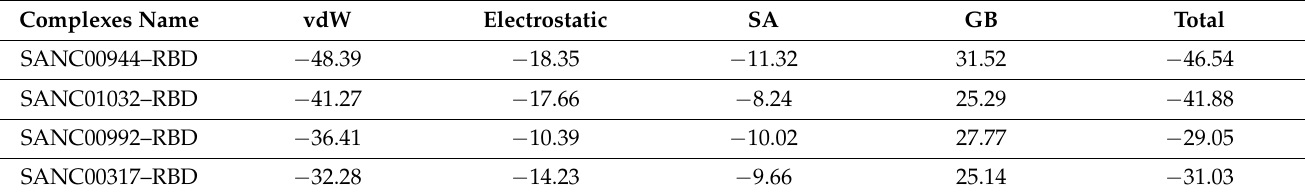
Table 3. MM/GBSA results for all the complexes including vdW (Van Der Waal), electrostatic energy, and the total binding energy. All the energies are given in kcal/mol.